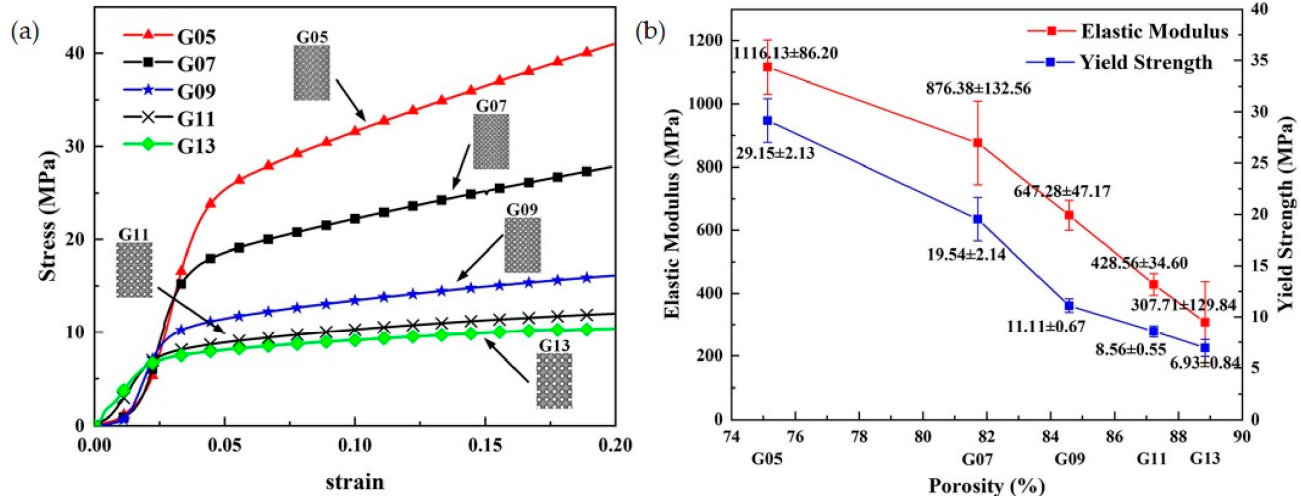
Figure 5. ( a ) Nominal stress–strain curves of G05–G13 structures (G represents gyroid). ( b ) Drop curve between porosities and measured elastic moduli and yield strengths of as-built samples (Adapted with permission from Ma et al., 2020).[75].